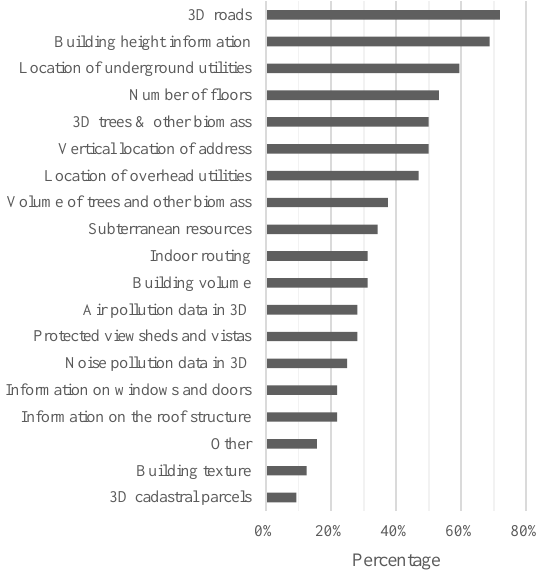
Figure 2. If you had access to any of the following 3D information, which would you use in your day-to-day work? ( n =32) Figure 2 shows the wide range of potential 3D geographic information selected by the participants. The top six include: 3D roads (72%); building height (69%); location of